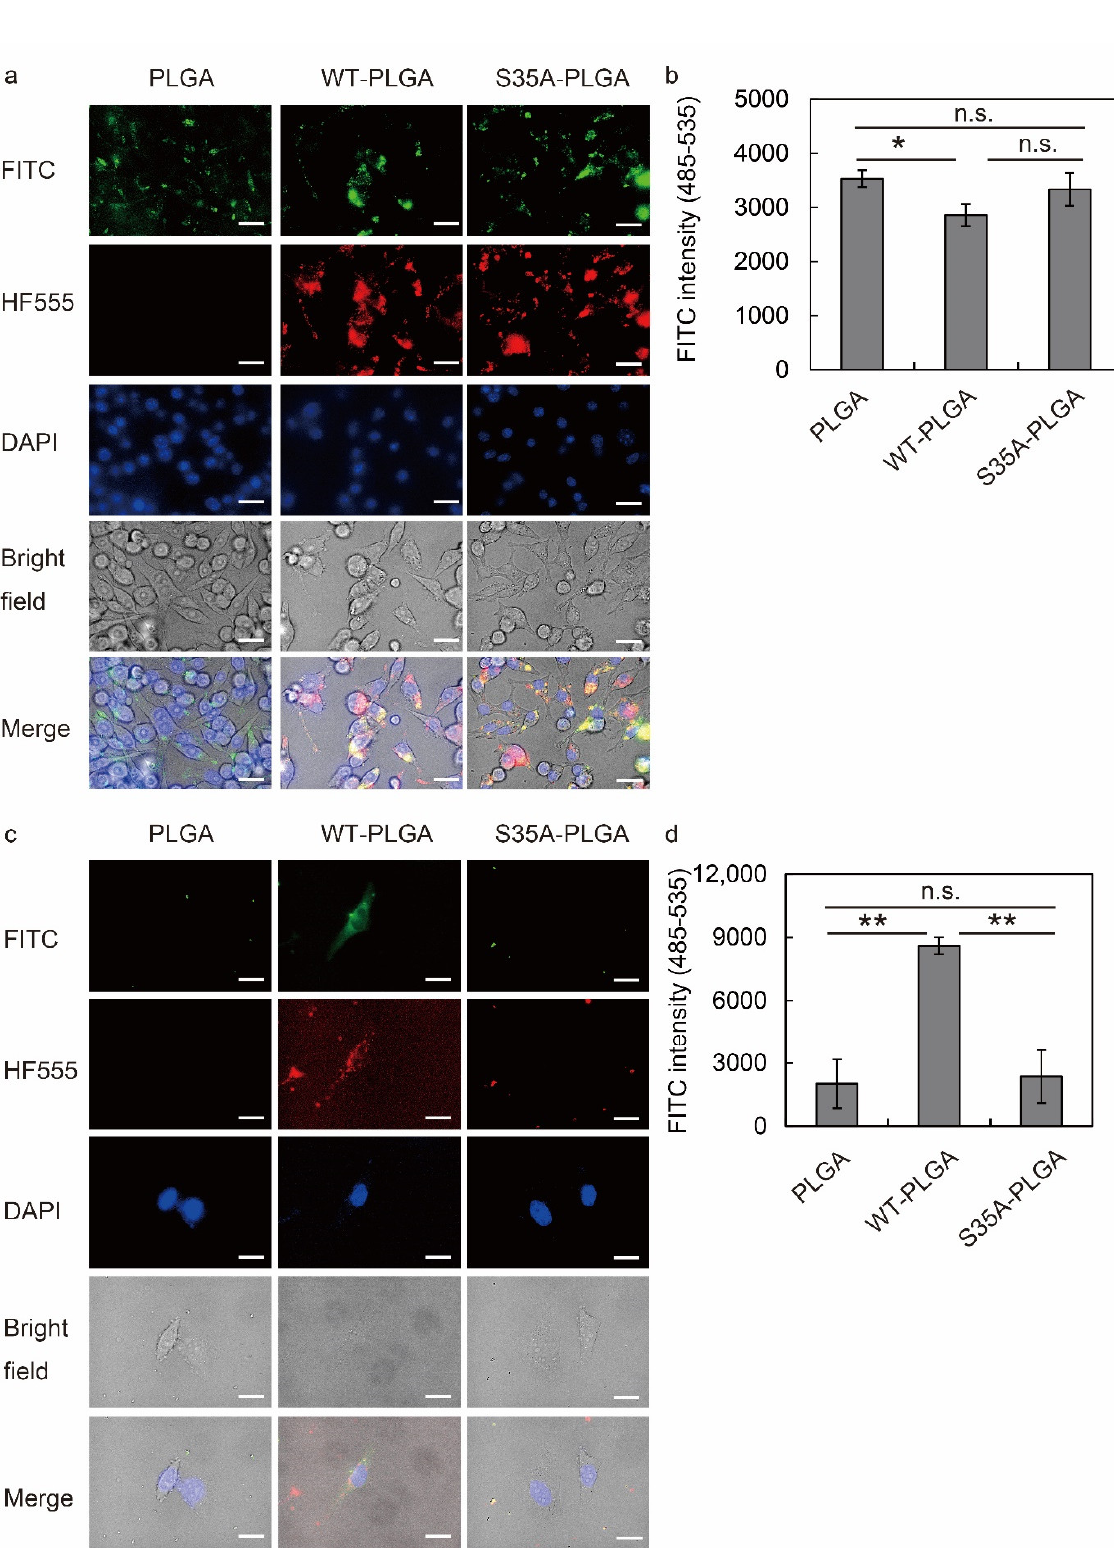
Figure 5. Uptake of SubAB-PLGA NPs by RAW264.7 and HeLa cells. RAW264.7 ( a , b ) and HeLa ( c , d ) cells were treated with 5 μg/mL FITC-labeled PLGA NPs modified with or without HF555-labeled WT or S35A. After incubation for 20 h, intracellular localization of fluorescent dye-labeled PLGA NPs and toxins was analyzed by fluorescence microscopy ( a , c ) and a fluorescence microplate reader ( b , d ). Scale bars: 10 μm. Data are expressed as means ± S.D. ( n = 3). Statistical analyses were performed using Student’s t -test. n.s., not significant. * p < 0.05, ** p < 0.01.